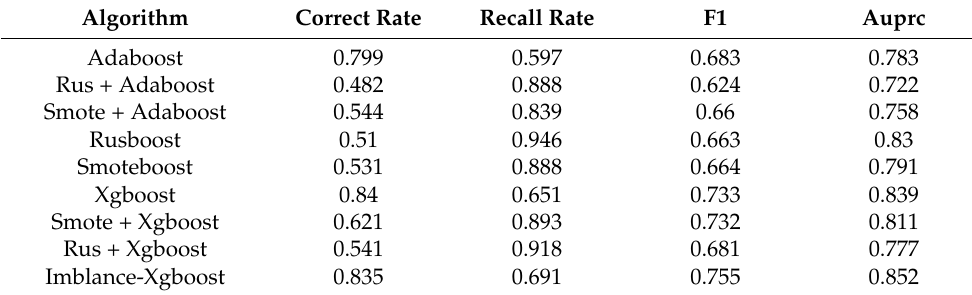
Table 3. Algorithm performance